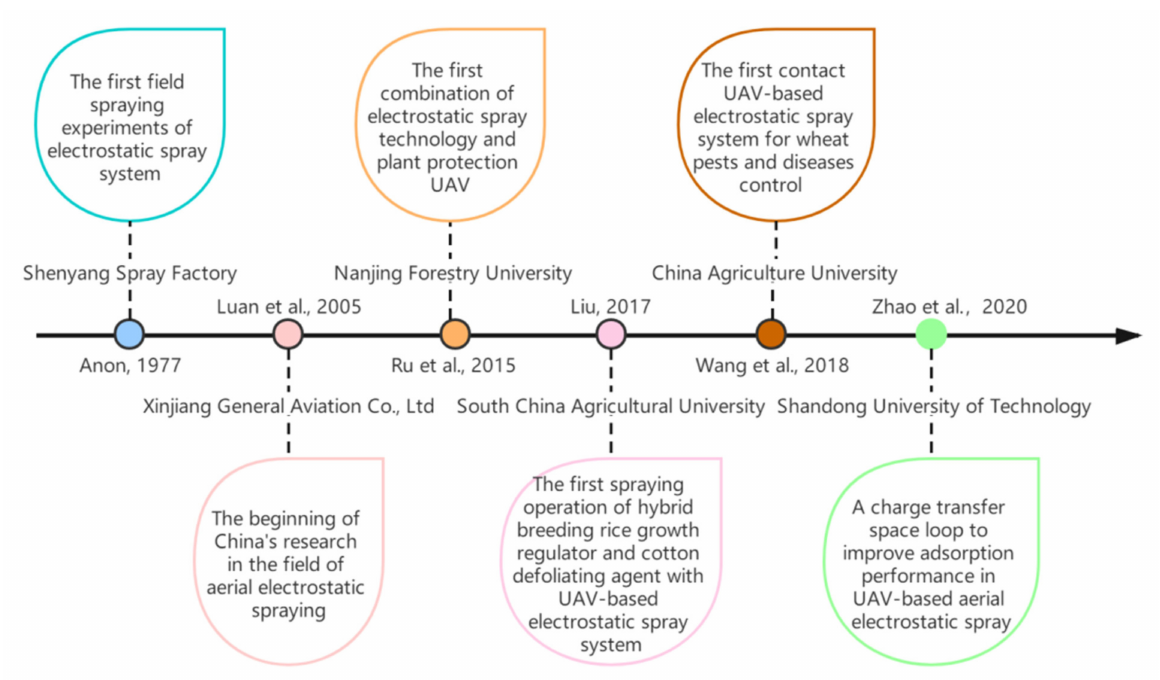
Figure 6. Key milestones and research groups working on aerial electrostatic spray